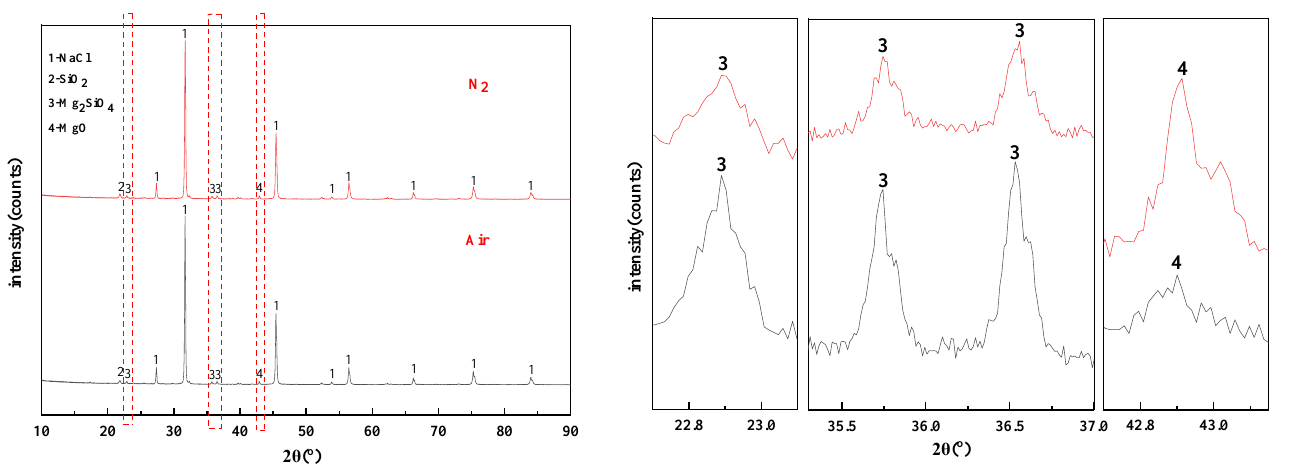
It can be seen from Figure 14 that the X-ray diffraction peaks of the filtrate under the two atmospheric conditions were similar in position and intensity, and they were all diffraction peaks of NaCl. The content of impurity elements in the filtrate decreased when the reaction atmosphere changed from air to N 2 . It is known that the N 2 is favourable to obtain high-quality molten NaCl. The effect of phase transition atmosphere on the phase of filter residues are shown in Figure 15. The influence of the phase transition atmosphere on the phase of filter residues is weak and the type of filter residues phase does not change significantly. The substances contained in the filter residues are NaCl, SiO 2 , Mg 2 SiO 4 , and MgO.